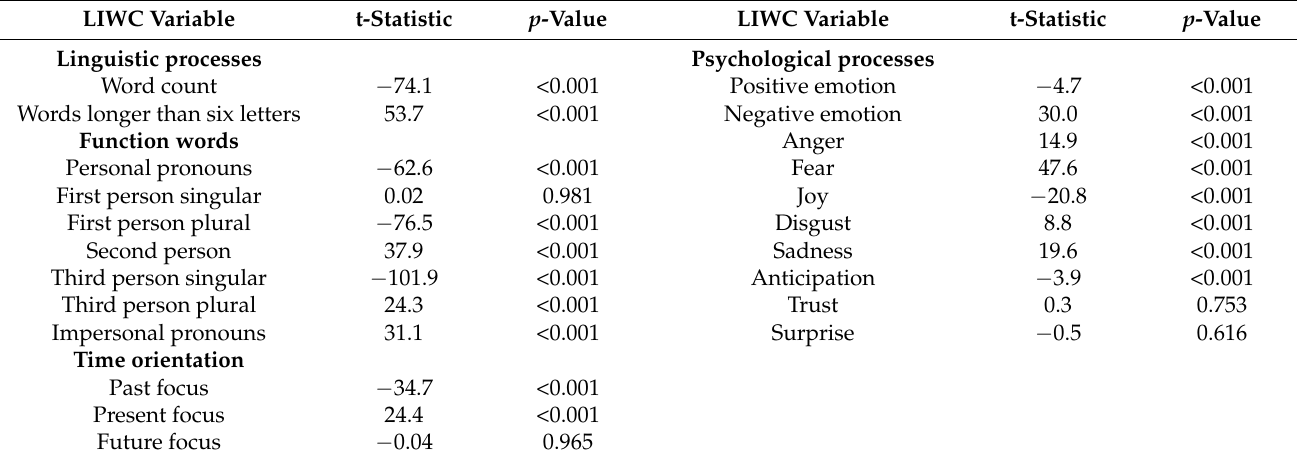
Table 2. Pairwise t-test results of the linguistic features between the schizophrenia and the control groups.